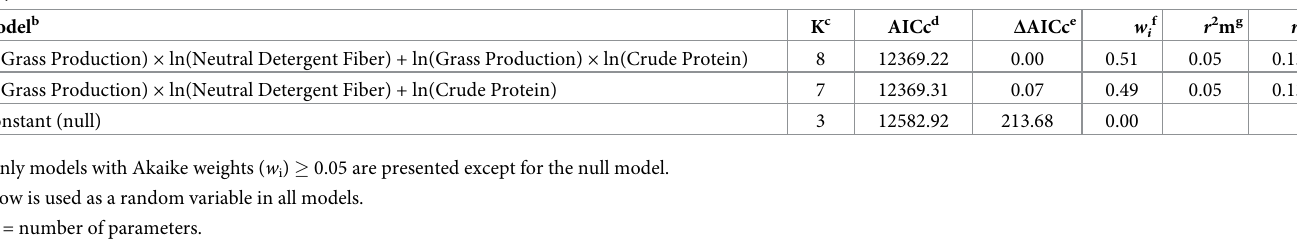
Table 4. Model selection for models evaluating the effects of vegetation chemical composition and production, cow age, body condition, body weight and supple- ment intake on grazing resource utilization by cattle grazing dormant rangeland in 2016 – 2017 & 2017 – 2018 at the Northern Agricultural Research Center Thack- eray ranch, Havre,